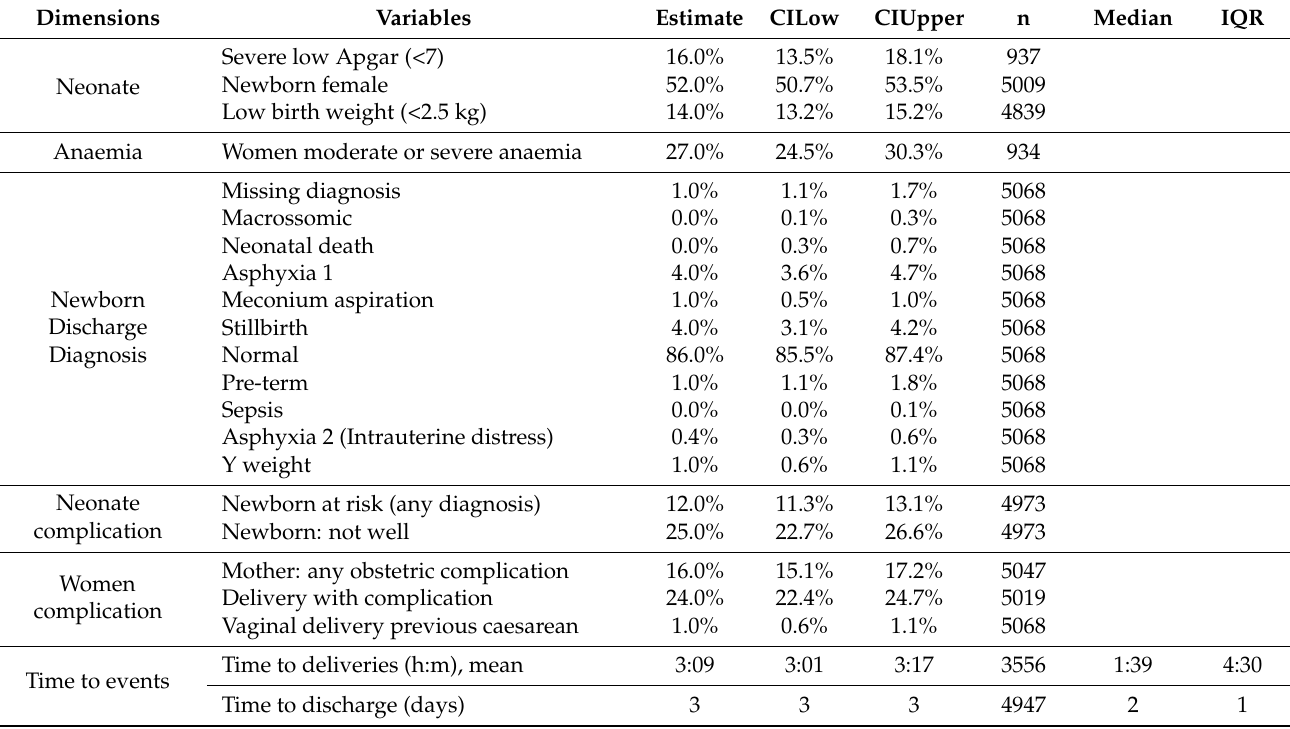
Table A2. Obstetric cases extended demographic and clinical profile, Chicuque, Chokwe and Manhiça hospitals, Southern Mozambique